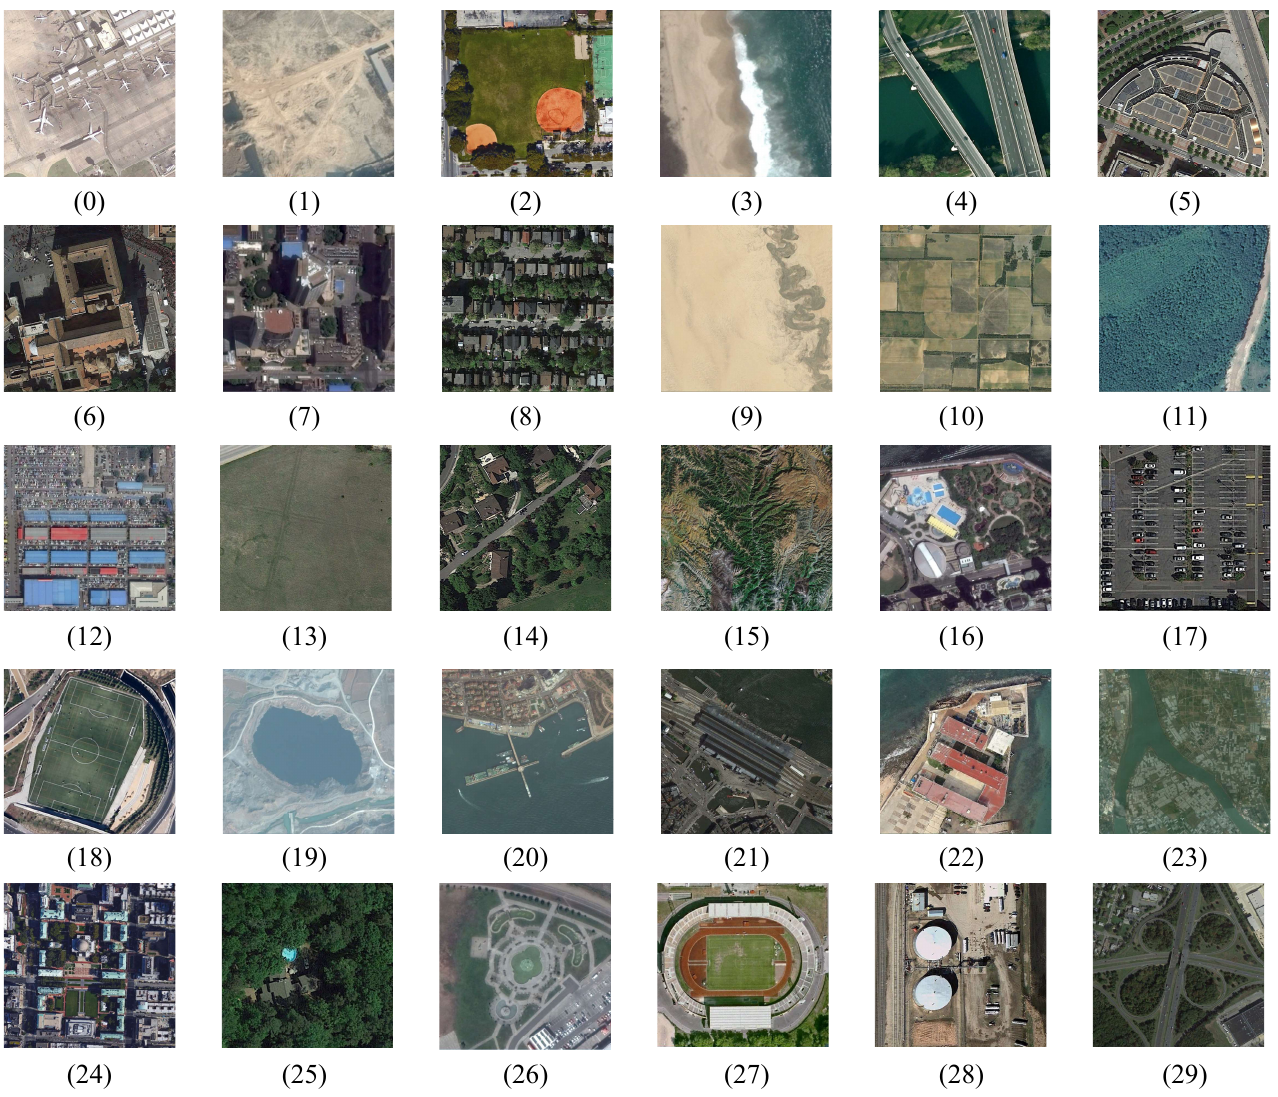
Figure 8. Some examples from the AID dataset. (0) Airport, (1) bare land, (2) baseball field, (3) beach, (4) bridge, (5) center, (6) church, (7) commercial, (8) dense residential, (9) desert, (10) farmland, (11) forest, (12) industrial, (13) meadow, (14) medium residential, (15) mountain, (16) park, (17) parking, (18) playground, (19) pond, (20) port, (21) railway station, (22) resort, (23) river, (24) school, (25) sparse residential, (26) square, (27) stadium, (28) storage tank, (29)